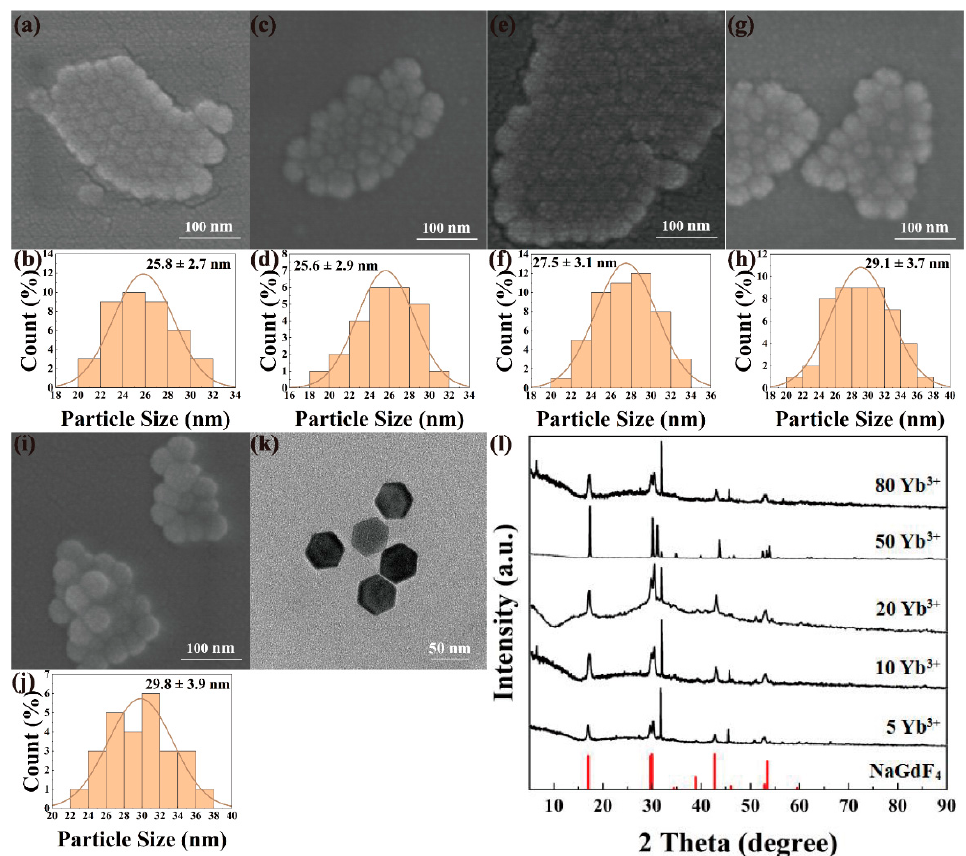
Figure 3. SEM, particle size analysis, TEM and XRD images of NaGdF 4 : x%Yb 3+ , 0.5%Tm 3+ . SEM: ( a ) x = 5, ( c ) x = 10, ( e ) x = 20, ( g ) x = 50, ( i ) x = 80; particle size analysis: ( b ) x = 5, ( d ) x = 10, ( f ) x = 20, ( h ) x = 50, ( j ) x = 80; ( k ) TEM image of NaGdF 4 : 20%Yb 3+ , 0.5%Tm 3+ ; ( l ) XRD of NaGdF 4 :x%Yb 3+ ,0.5%Tm 3+ (x = 5, 10, 20, 50, 80).